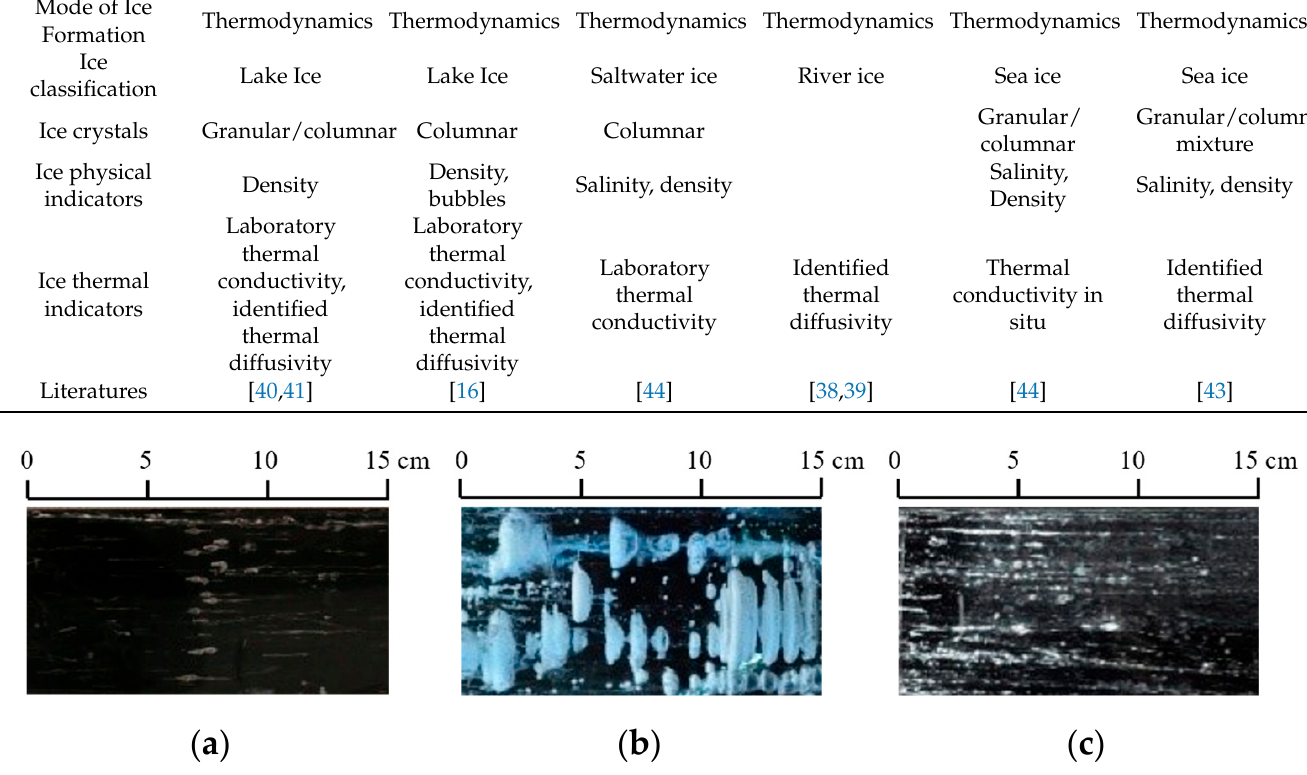
Figure 4. The bubbles in different freshwater ice in China are ( a ) sword-headed bubbles in Hongqibao Reservoir, 28 December 2008 (modified from Ref. [42]); ( b ) spine-shaped bubbles in the Thermakarst Lake of Beiluhe on the Qinghai-Tibet Plateau, 9 December 2010 (modified from Ref. [47]); and ( c ) linear granular bubbles in the Thermakarst Lake of Beiluhe on the Qinghai-Tibet Plateau, 9 December 2010 (modified from Ref. [47]).